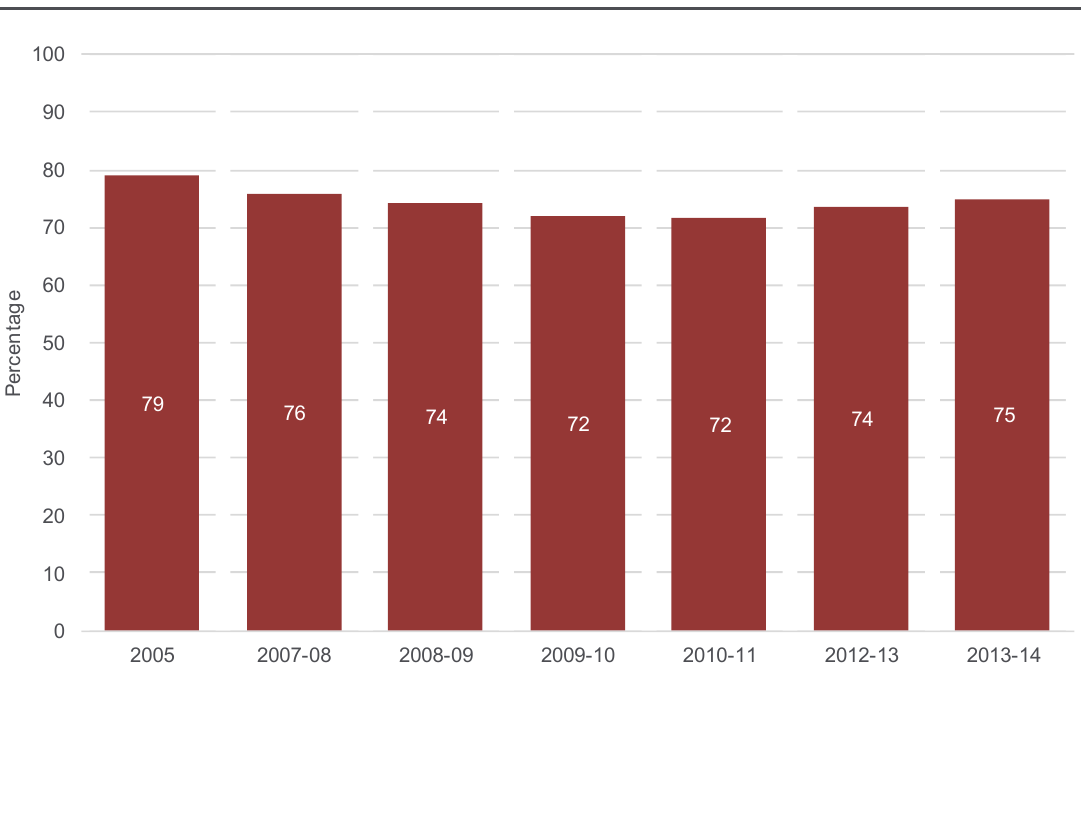
Figure 5: Whether people had given money to charity in the four weeks prior to being interviewed, 2005 to